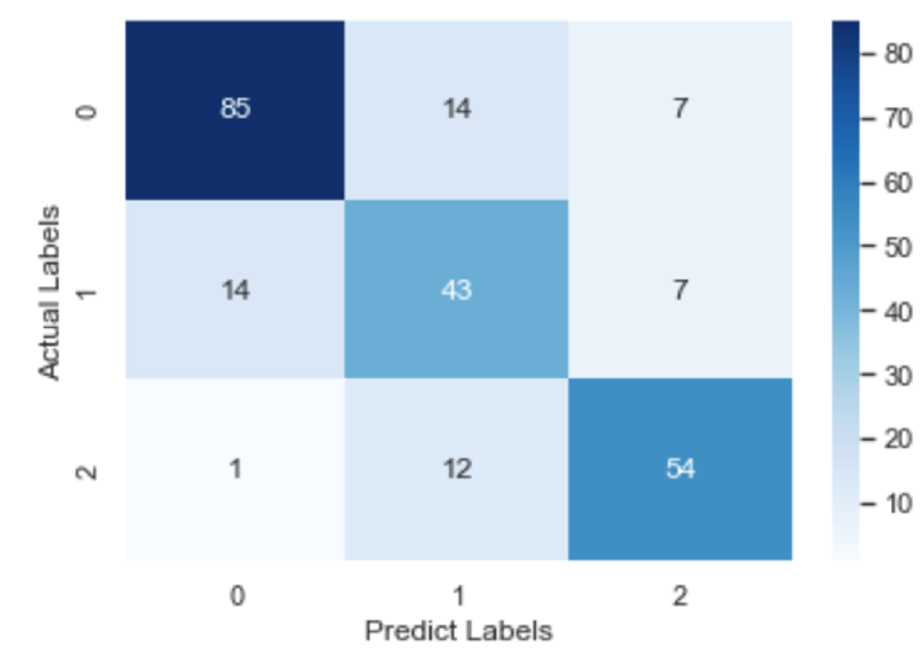
Figure 9. Confusion matrix of the CNN model.